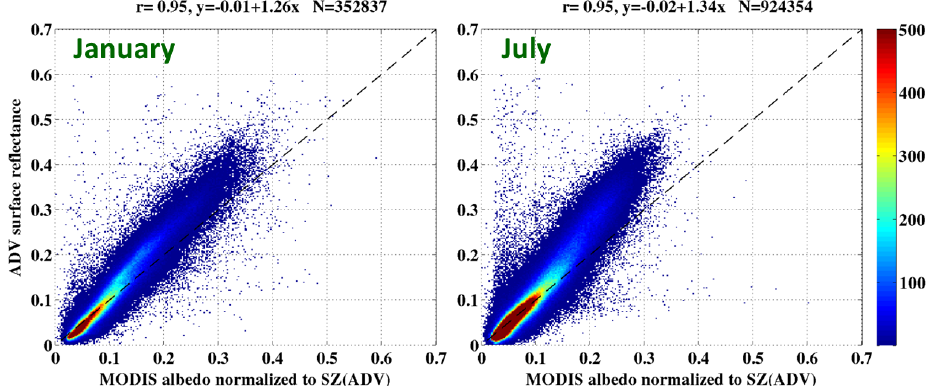
Figure 13. ADV vs MODIS point-to-point surface reflectances for 659 nm for January (left) and July (right). Color (legend) represents the frequency of the